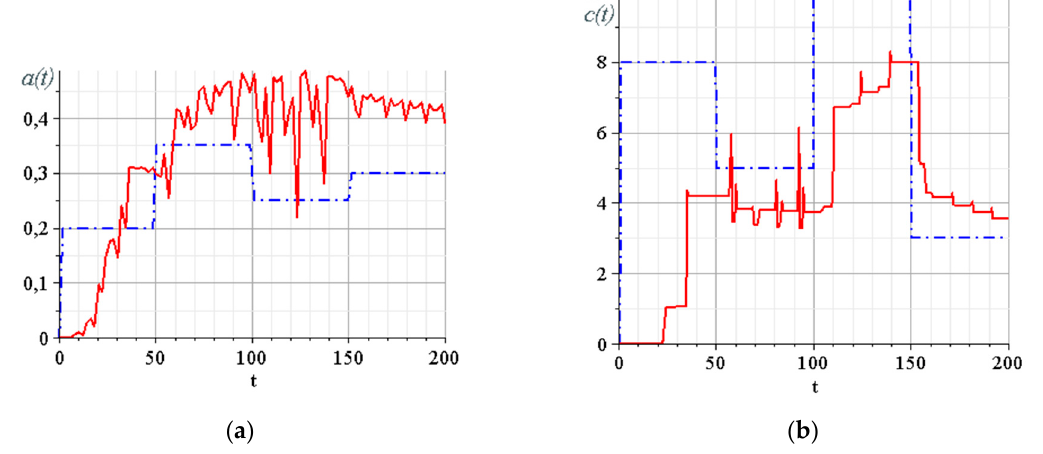
Figure 18. Useful signal reconstruction with a two channel LS method observer: ( a ) Useful signal a (blue is the initial signal at the transmitter side; and red is the reconstructed signal at the receiver side); ( b ) Useful signal c (blue is the initial signal at the transmitter side; and red is the reconstructed signal at the receiver side).